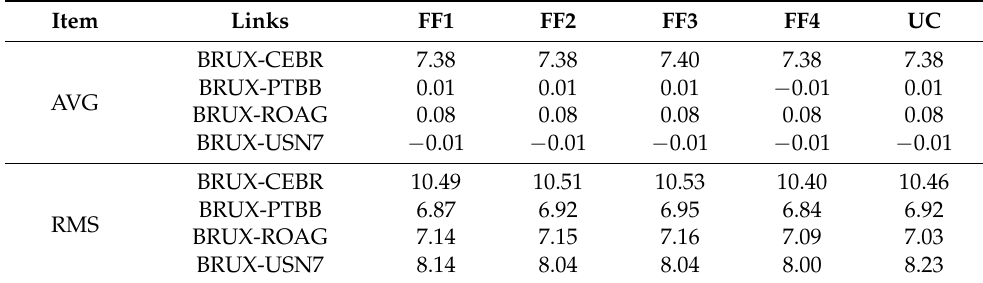
Table 5. Clock offset epoch difference results at four time-frequency links for the FF1, FF2, FF3, FF4 and UC PPP models on DOYs 190 to 196 in 2020 (ps).